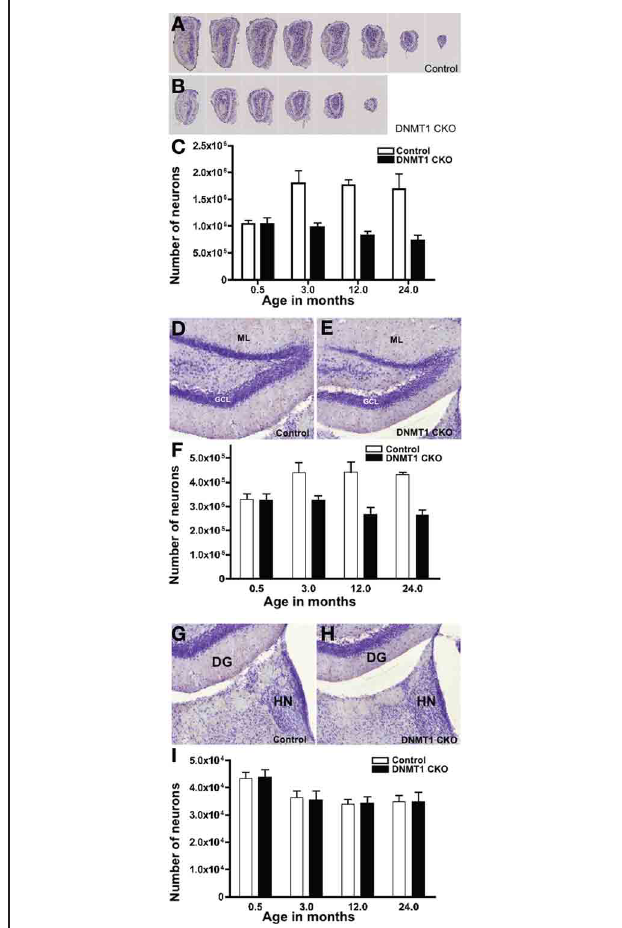
DG but normal development of medial habenula in DNMT1-cKO mice. (A,B) Evenly spaced sections through OB demonstrate the pronounced reduction in macroscopic size of OB in an adult DNMT1-cKO (B) mouse in comparison with an age-matched control (A) . (C) Stereological analysis showed a pronounced and statistically significant ( p < 0 . 001) 45% increase in the total number of GCL neurons in OB of control mice between 0.5 and 3 months of age, with no further significant change at 12 or 24 months. In the contrast, the total number of GCL neurons in OB of DNMT1-cKO mice did not change significantly between 0.5 and 3 months of age and declined slightly at 12 and 24 months (ANOVA with Neuman–Keuls pairwise analysis, all groups n = 6). (D,E) The DG granule cell layer (GCL) in an adult DNMT1-cKO (E) mouse is visibly thinner in comparison with an age-matched control (D) . ML, molecular layer. (F) Stereological analysis showed a pronounced and statistically significant ( p < 0 . 001) 25% increase in the total number of GCL neurons in DG of control mice between 0.5 and 3 months of age, with no further significant change at 12 or 24 months. In contrast, the total number of GCL neurons in DG of DNMT1-cKO mice did not change significantly between 0.5 and 3 months of age and declined slightly at 12 and 24 months (ANOVA with Neuman–Keuls pairwise analysis, all groups n = 6). (G,H) The medial habenular nucleus (HN) in an adult DNMT1-cKO (H) mouse does not differ visibly in appearance from that in an age-matched control (G) . (I) Stereological analysis showed no statistically significant difference between the total numbers of neurons in HN of DNMT1-cKO and control mice at any age, but did reveal a significant 20% reduction between 0.5 months and all other ages ( p < 0 . 001 ANOVA with Neuman–Keuls pairwise analysis, all groups n = 4) in both DNMT1-cKO and control